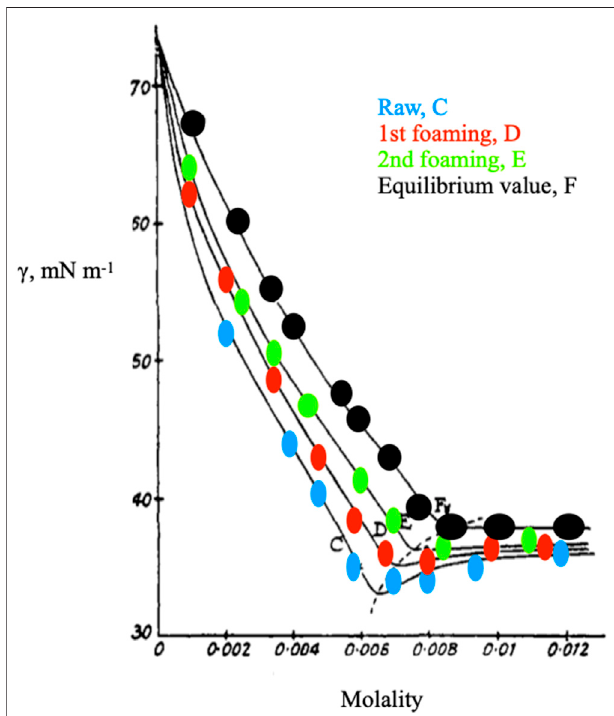
FIGURE 2 | Data redrawn from Ref.s (Elworthy and Mysels, 1966; Mysels, 1986), showing surface tension changes by foam puri fi cation. The dotted line indicates the shift of the cmc upon progressive de-foaming. The cmc value inferred by ionic conductance is 8.21 10 − 3 mol kg − 1 , at 25.00 ° C. It corresponds to the in fl ection point of the curve indicated by black points and is obtained with highly puri fi ed sodium dodecylsulfate, SDS.